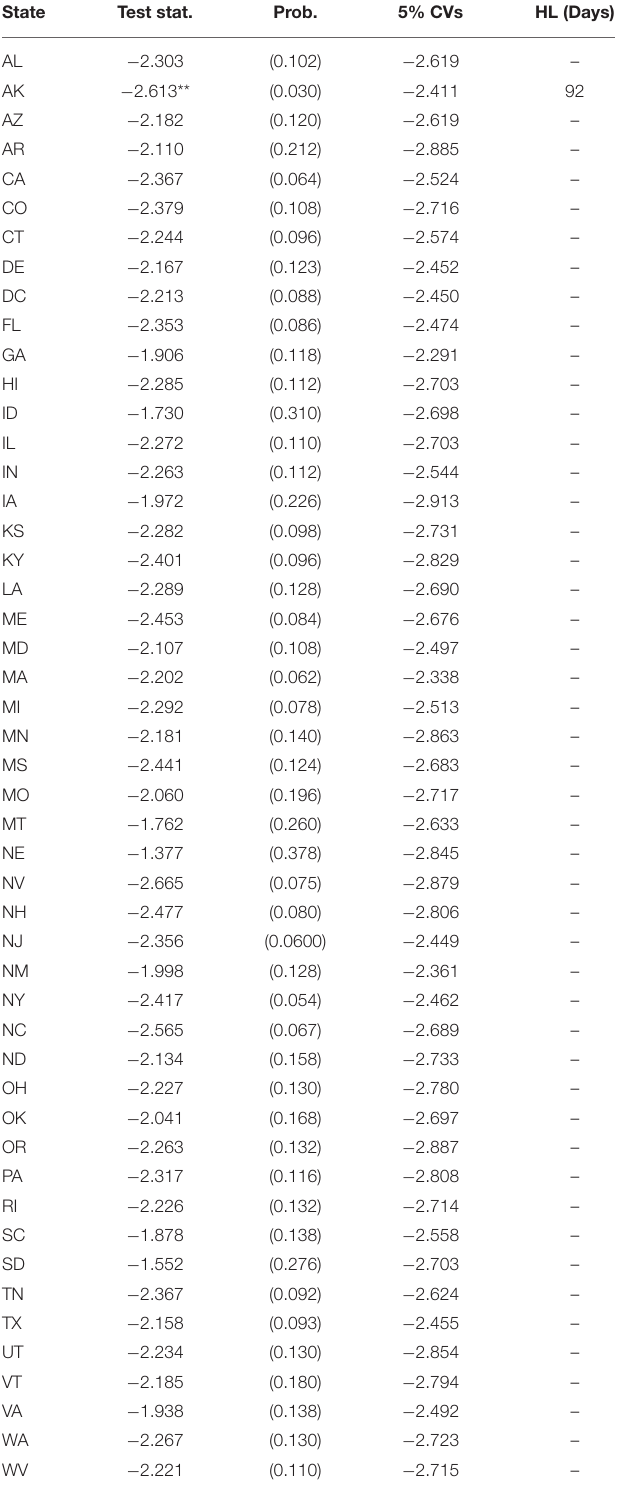
TABLE 3 | Results of the bootstrap unit-root test for a random walk with drift (small businesses openings, leisure and hospitality). State Test